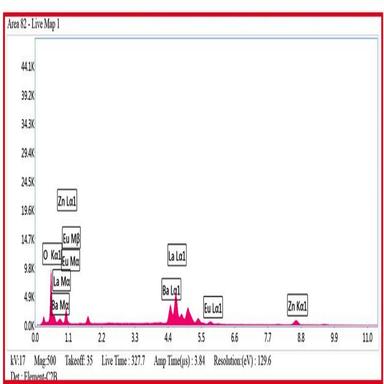
EDAX analysis of optimal nanophosphor Ba2La3.8Eu0.2Zn2O10 shows quantitatively the presence of various elements in the nanophosphor.